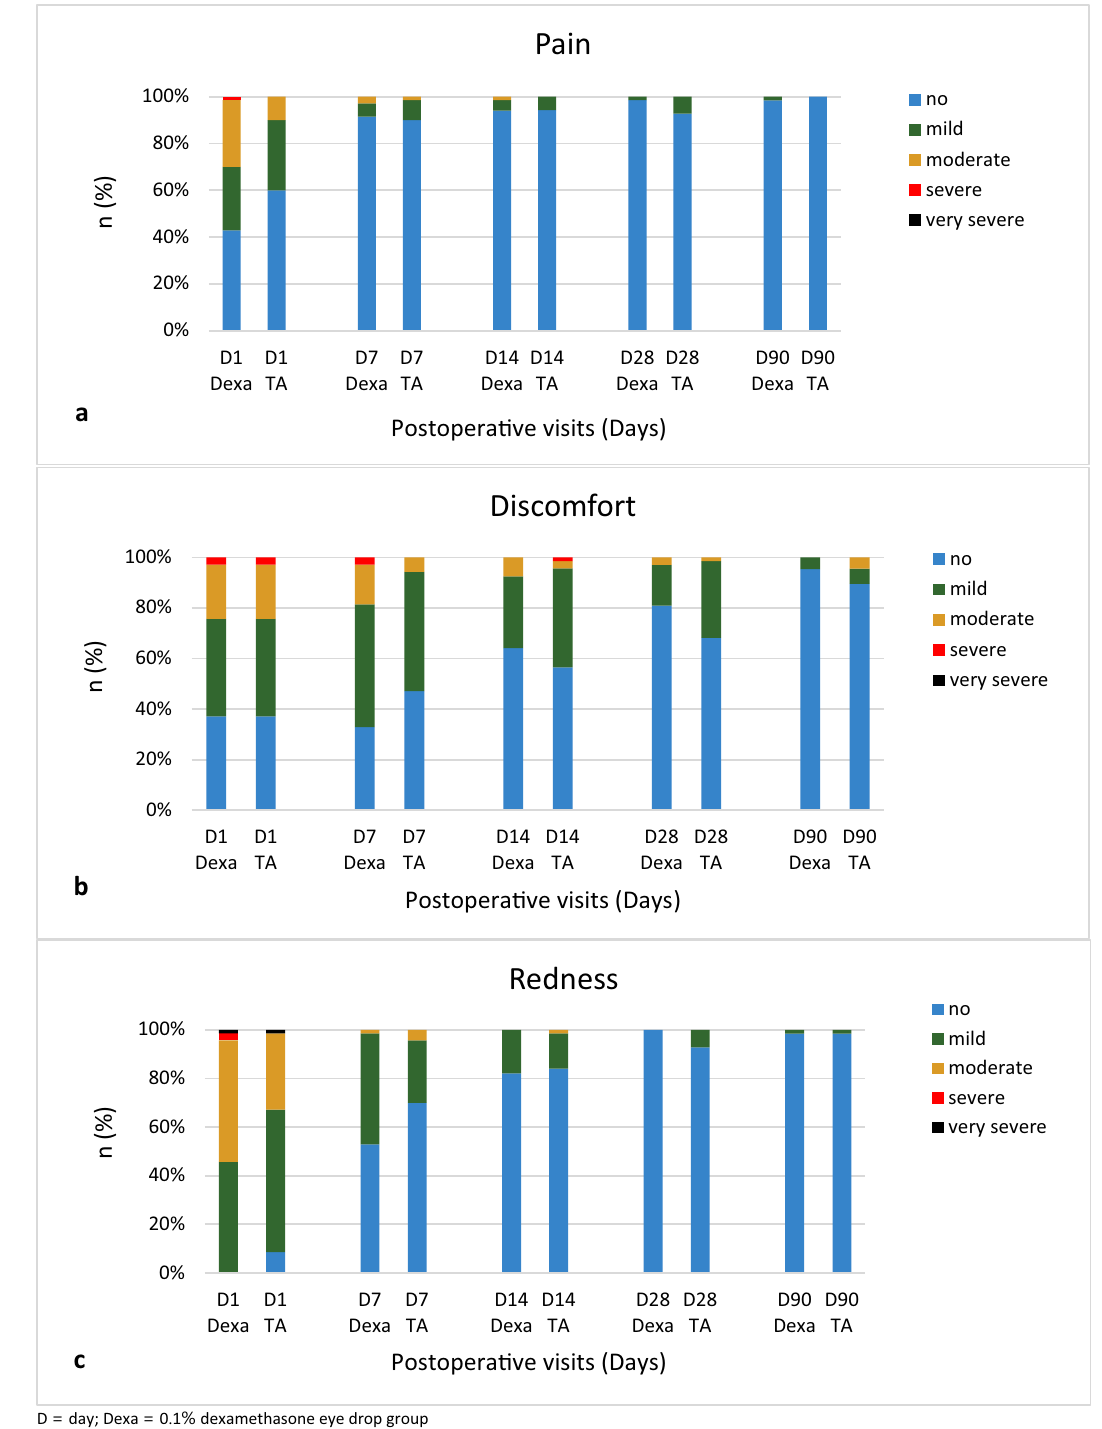
Figure 2. Grades of pain ( a ), discomfort ( b ), and redness ( c ) at each study visit. Mild to moderate pain, discomfort, and redness were observed during early postoperative period and gradually